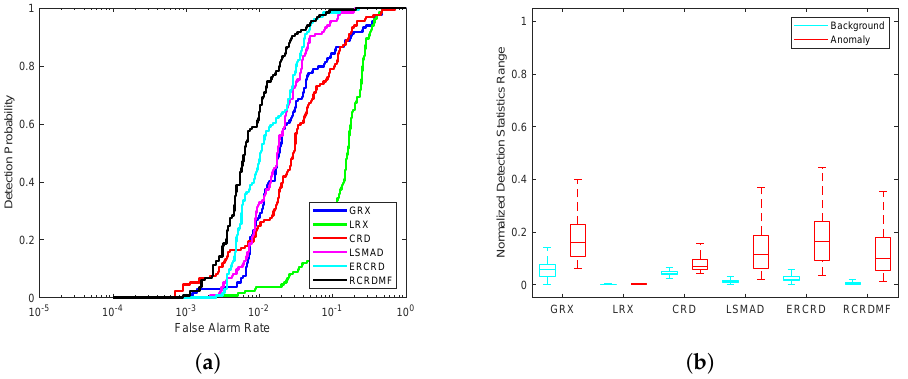
Figure 8. Detection accuracy evaluation for the AVIRIS-II dataset. ( a ) ROC curves. ( b ) Normalized background-anomaly separation